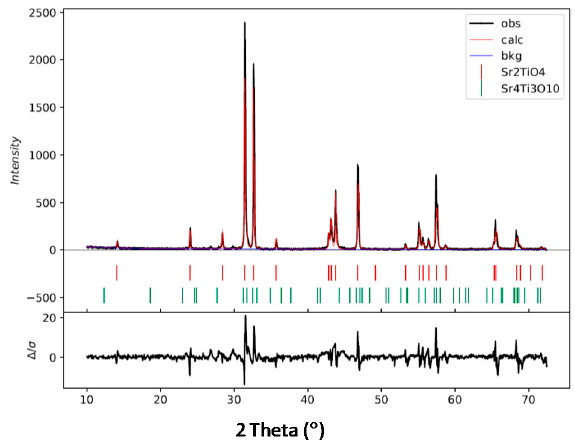
Figure 8. The experimental XRD pattern of MA-2 annealed at 1100 ° C (black) and the theoretical one calculated using a model of crystal structure Sr 2 TiO 4 [39-1471] (red). The bottom line is the difference plot between observed and calculated values.